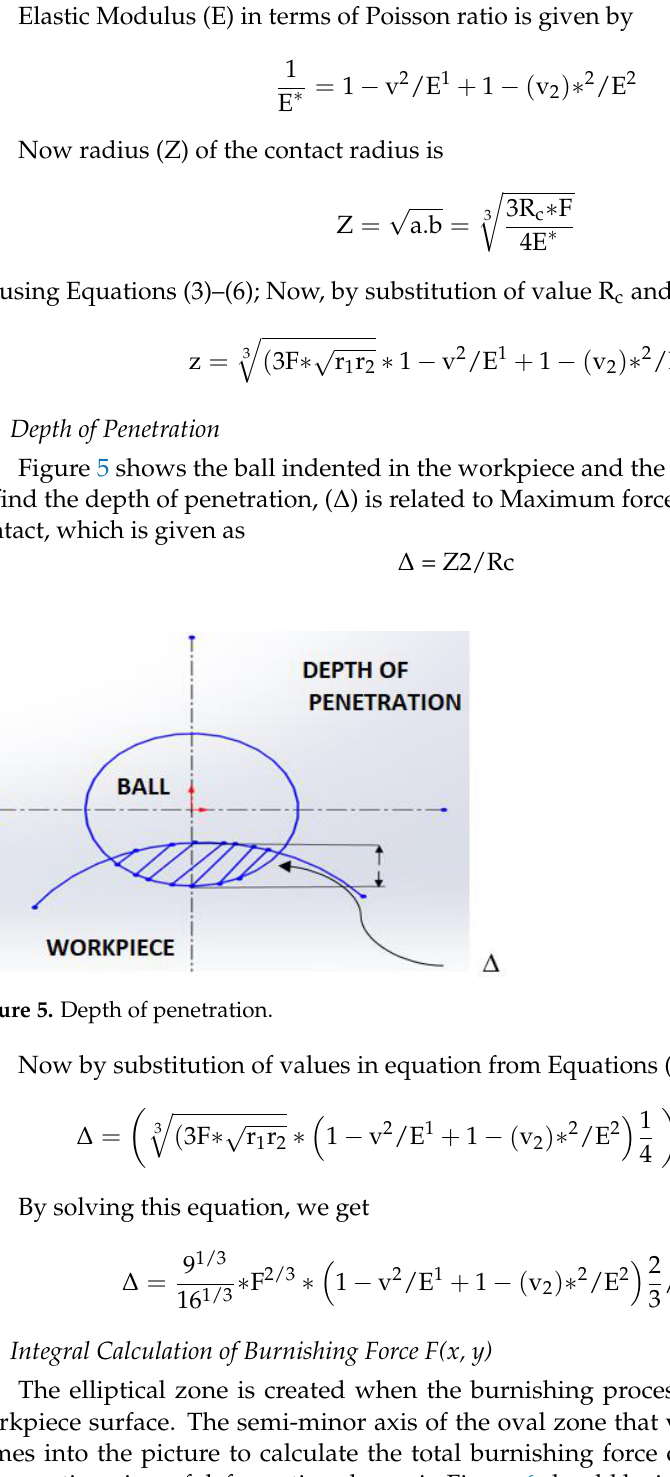
Figure 4. Cross-section to find contact radius.